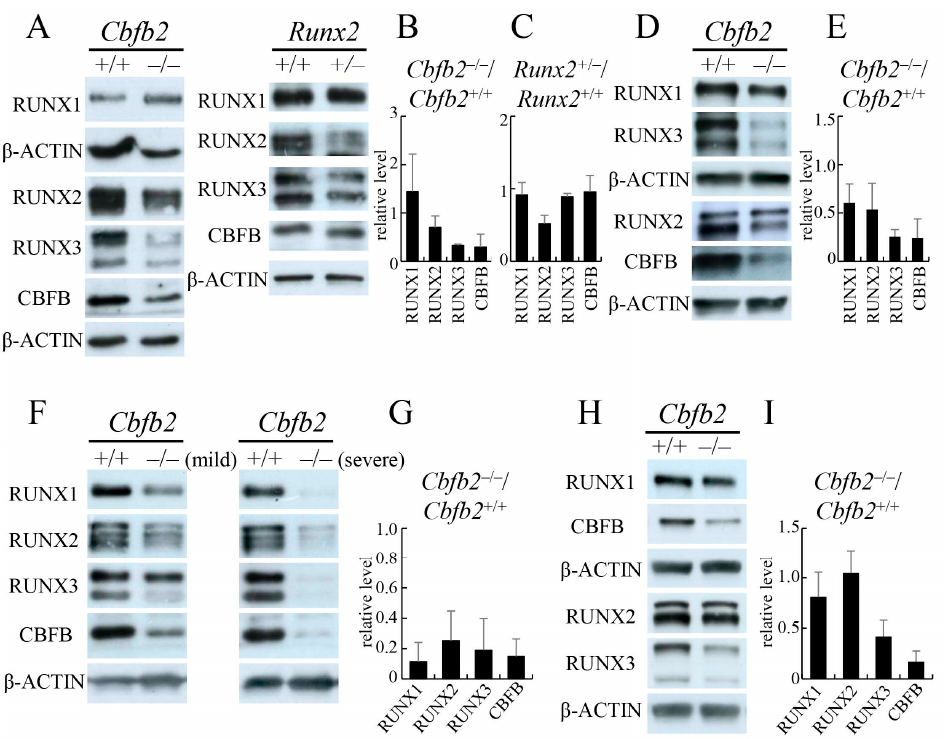
Figure 1. Western blot analysis of RUNX family proteins and CBFB. Proteins were extracted from calvaria ( A – C ), the trabecular bone in femurs and tibiae ( D , E ), ribs ( F , G ) and vertebrae ( H , I ) at 4 weeks of age in Cbfb2 +/+ , Cbfb2 –/– , Runx2 +/+ and Runx2 +/– mice. Representative data are shown in ( A ), ( D ), ( F ), and ( H ). β‐ ACTIN was used as an internal control. The intensities of bands were normalized against β‐ ACTIN, and the normalized values in Cbfb2 +/+ or Runx2 +/+ mice were set as 1. The means ± SD of the relative levels of Cbfb2 –/– mice ( B , E , G , I ) and Runx2 +/– mice ( C ) are shown. The number of mice analyzed: B, n = 3–5; C, n = 3; E, n = 4–5; G, n = 4; I, n = 4.